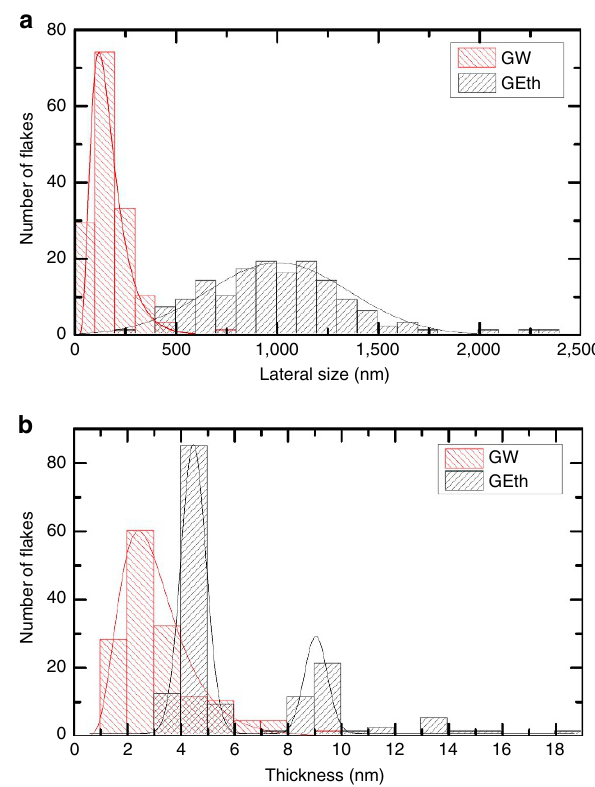
Figure 3 | Flakes distribution. ( a ) Flake lateral size distribution and ( b ) thickness, for water-based (GW) and ethanol-based (GEth)